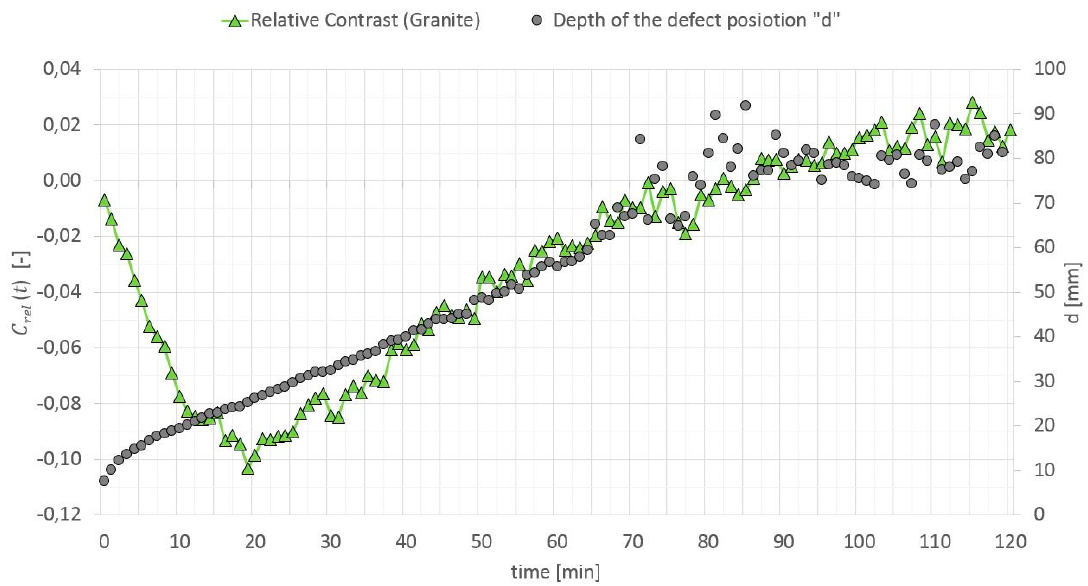
Figure 19. Relative contrast and defect location depth versus time (Granite).